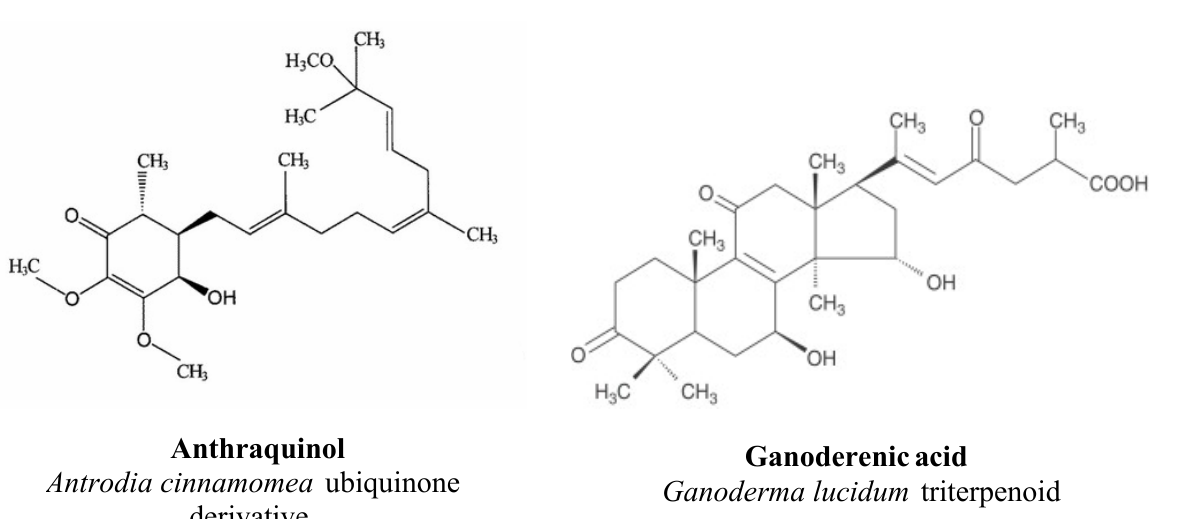
Figure 3. Two representative molecules obtained from mushrooms with hepatoprotective